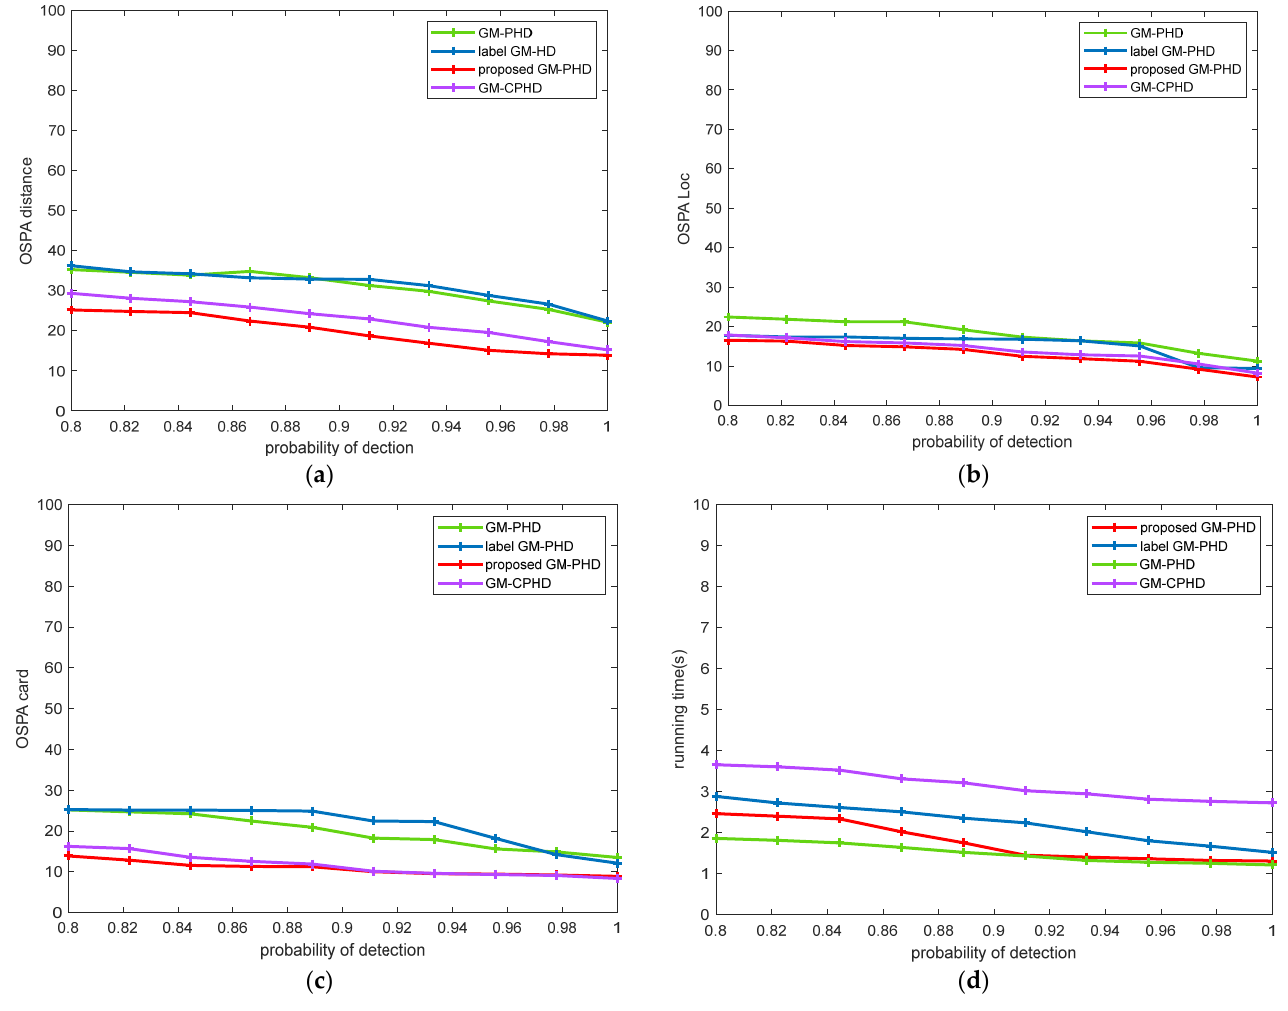
Figure 6. Comparison of the performance of different filters in a changing environment of detection probability: ( a ) OSPA distance comparison; ( b ) OSPA Location comparison; ( c ) target cardinalities estimation error; ( d ) running time comparison.